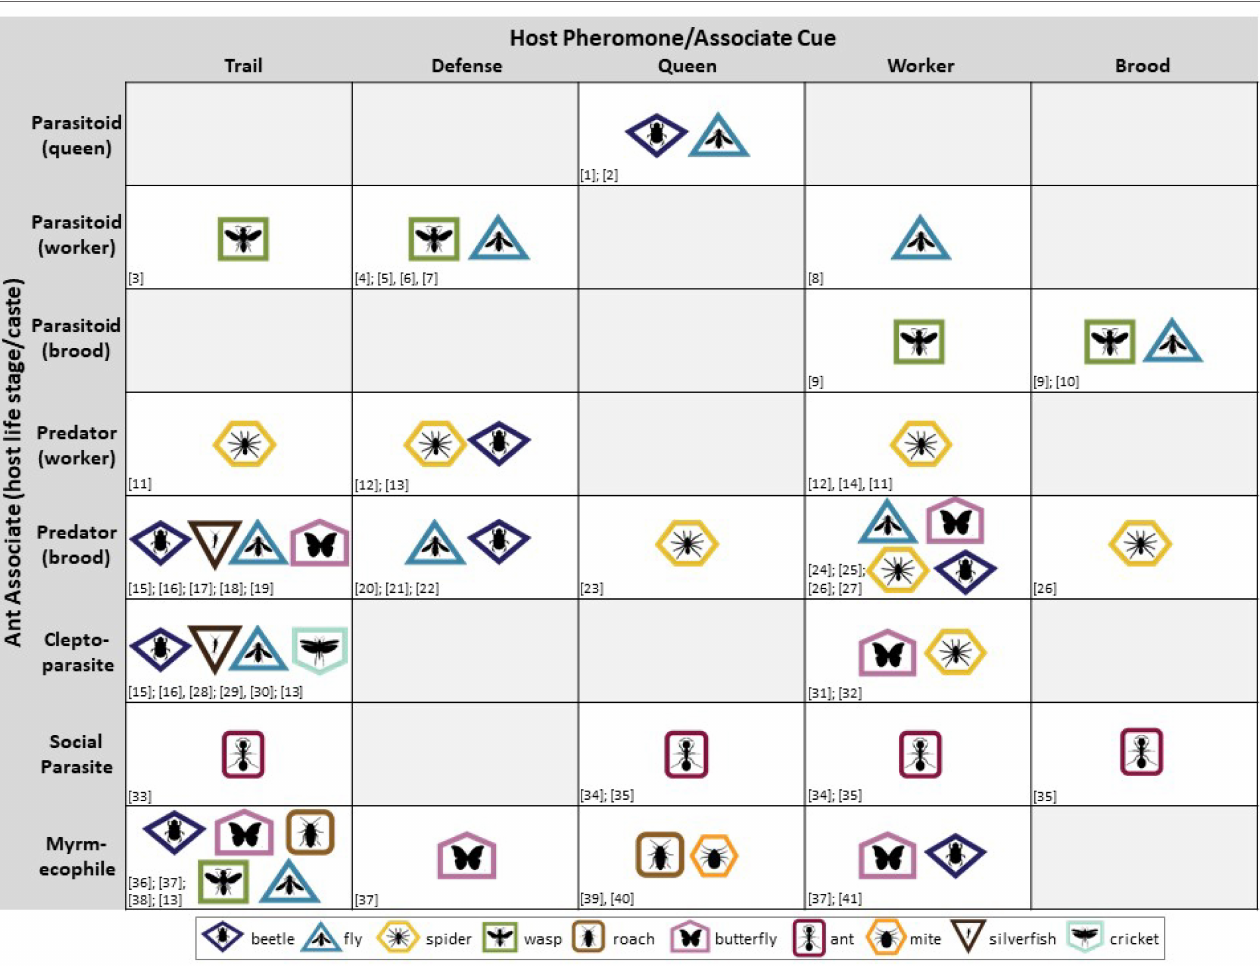
TABLE 1 | Demonstrated and putative chemical eavesdropping enemies and associates of the